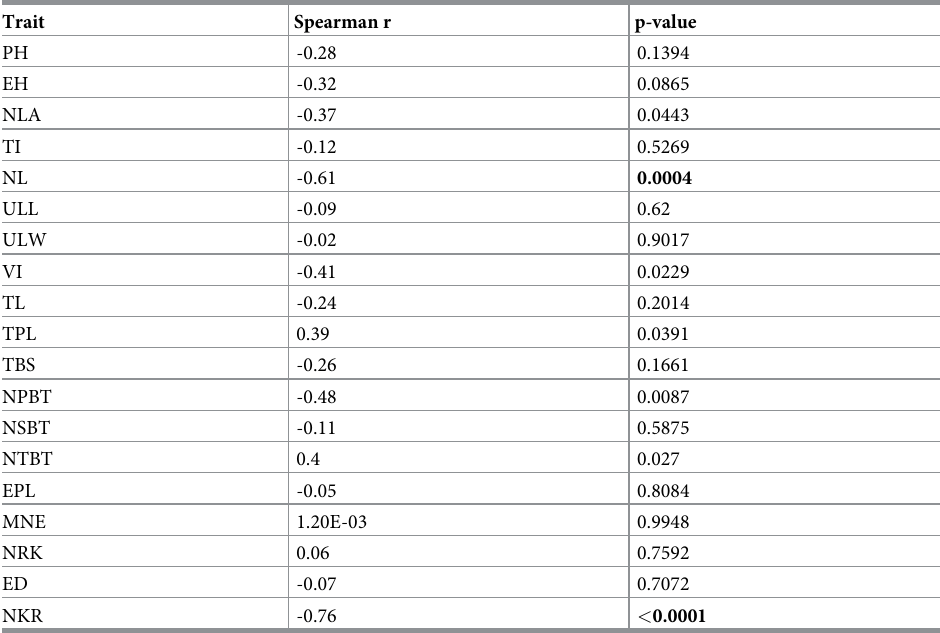
Table 3. Spearman correlation between agro-morphological traits and altitude.